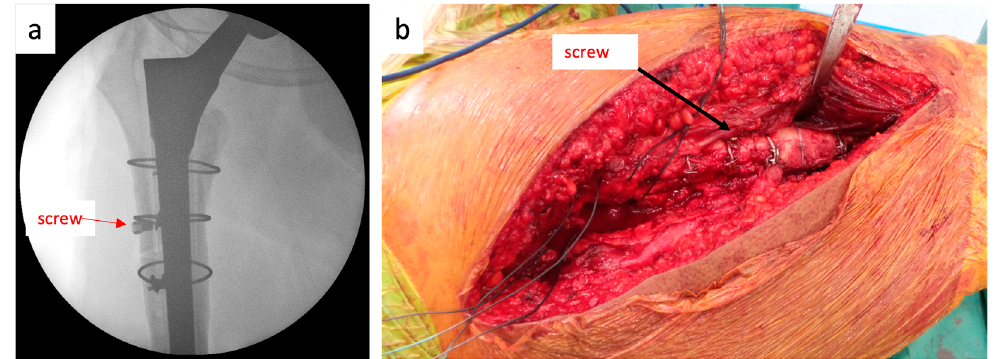
Figure 6. ( a ). Intraoperative fl uoroscopic image. Note the screw placed just distal to the cerclage fi xing the osteotomy. ( b ). Posterior intraoperative view showing the position of the screw just